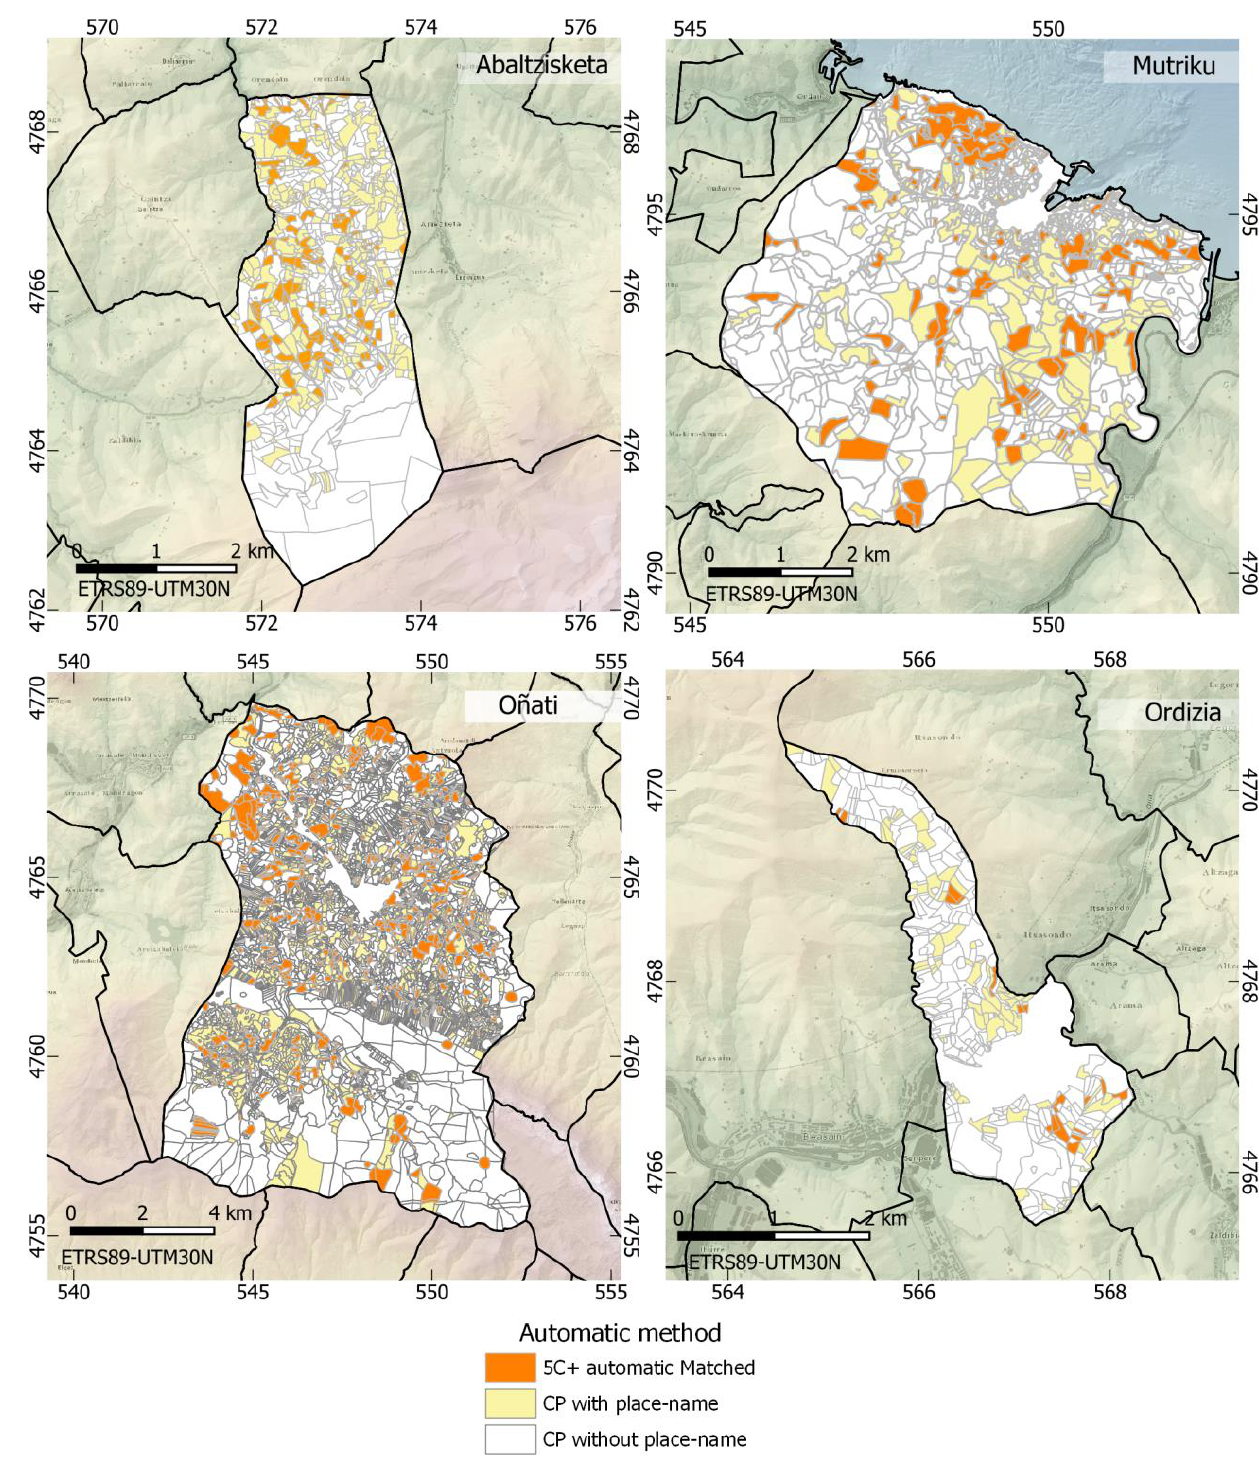
Figure 5. Cadastral parcels selected automatically (5C+ matching). Frame coordinates in km.